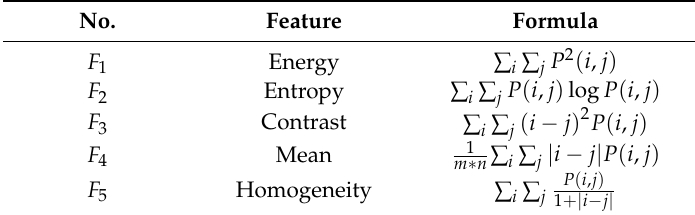
Table 1. Feature calculated from the normalized co-occurrence matrix P ( i , j ) . No.